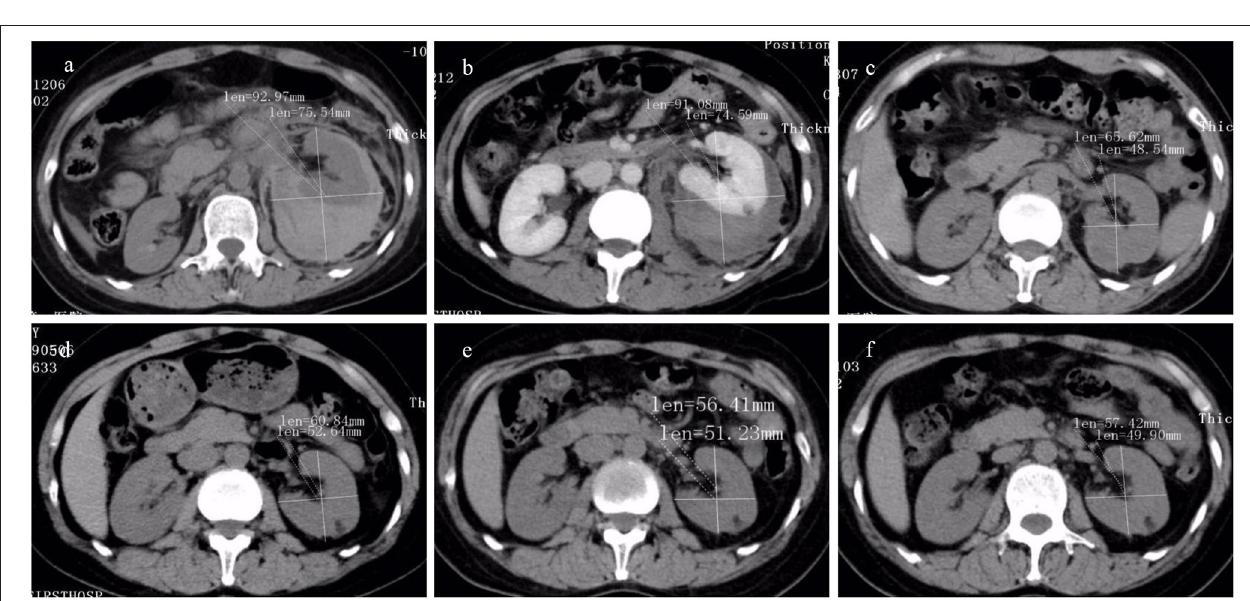
FIGURE 4 | The CT images of renal angiomyolipoma (rAML) size in preintervention and postintervention after transcatheter arterial embolization (TAE) (the same patient as in Figure 2 ) were showed. An inhomogeneous endophytic renal mass with low-attenuating areas of intra-tumoral fat. (a–f) CT images obtained at pre-TAE, and at follow-up period of 1 week, 1 month, 3 months, 6 months, and 12 months. A significant reduction in rAML size was depicted.